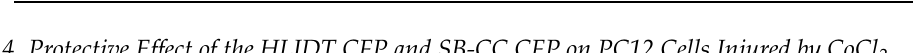
Table 4. Binding thermodynamics of baicalin and berberine.